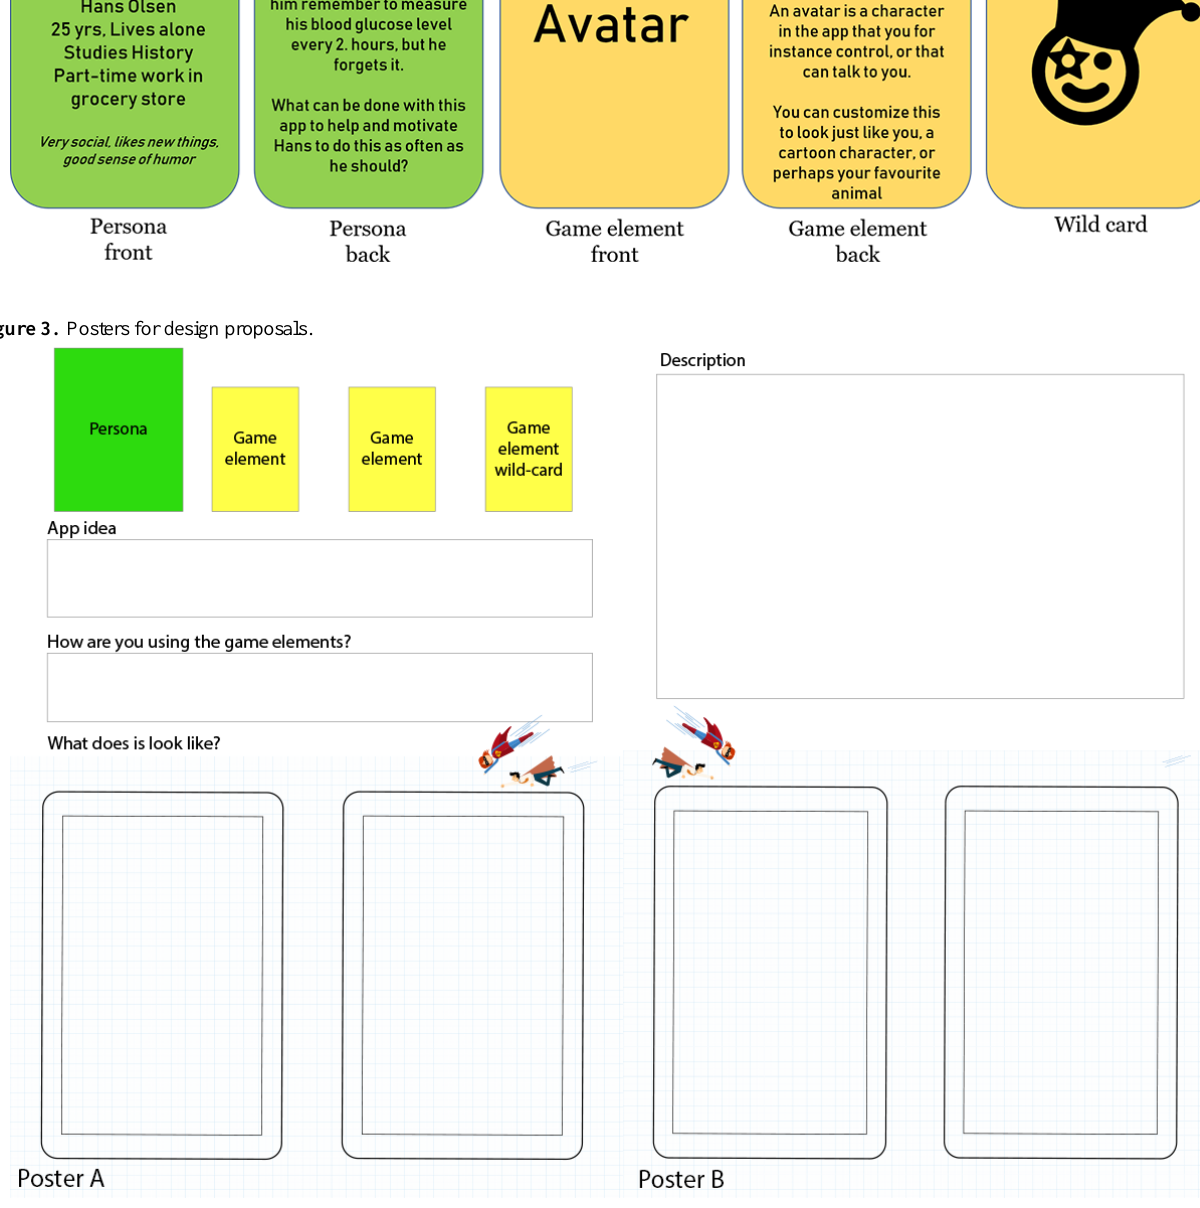
Figure 2. Cards from design game.